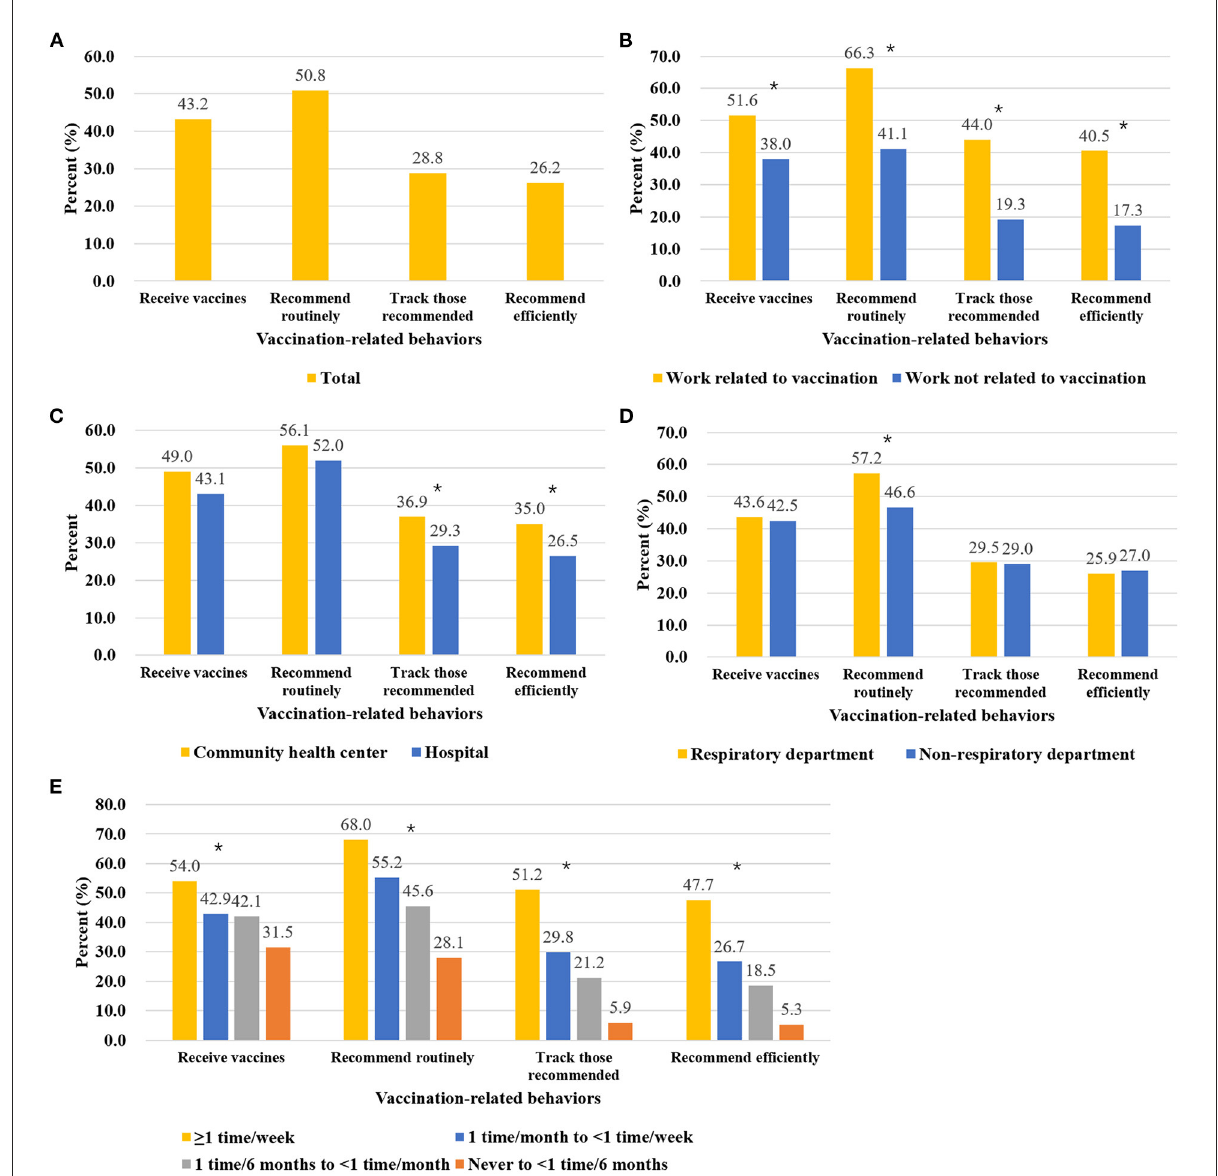
FIGURE3 Engagement in vaccination-related behaviors among different groups of participants. (A) Total participants. (B) Participants performing vaccination-related work or not. (C) Participants working in hospitals or community health centers. (D) Participants working in respiratory or non-respiratory departments. (E) Participants with different SDL frequencies. When evaluating the engagement in behaviors of tracking or efficient recommendation, only participants who recommend vaccination routinely were included. Chi-square tests were applied to test the difference among different groups of participants, and the *symbol indicates p-value of <